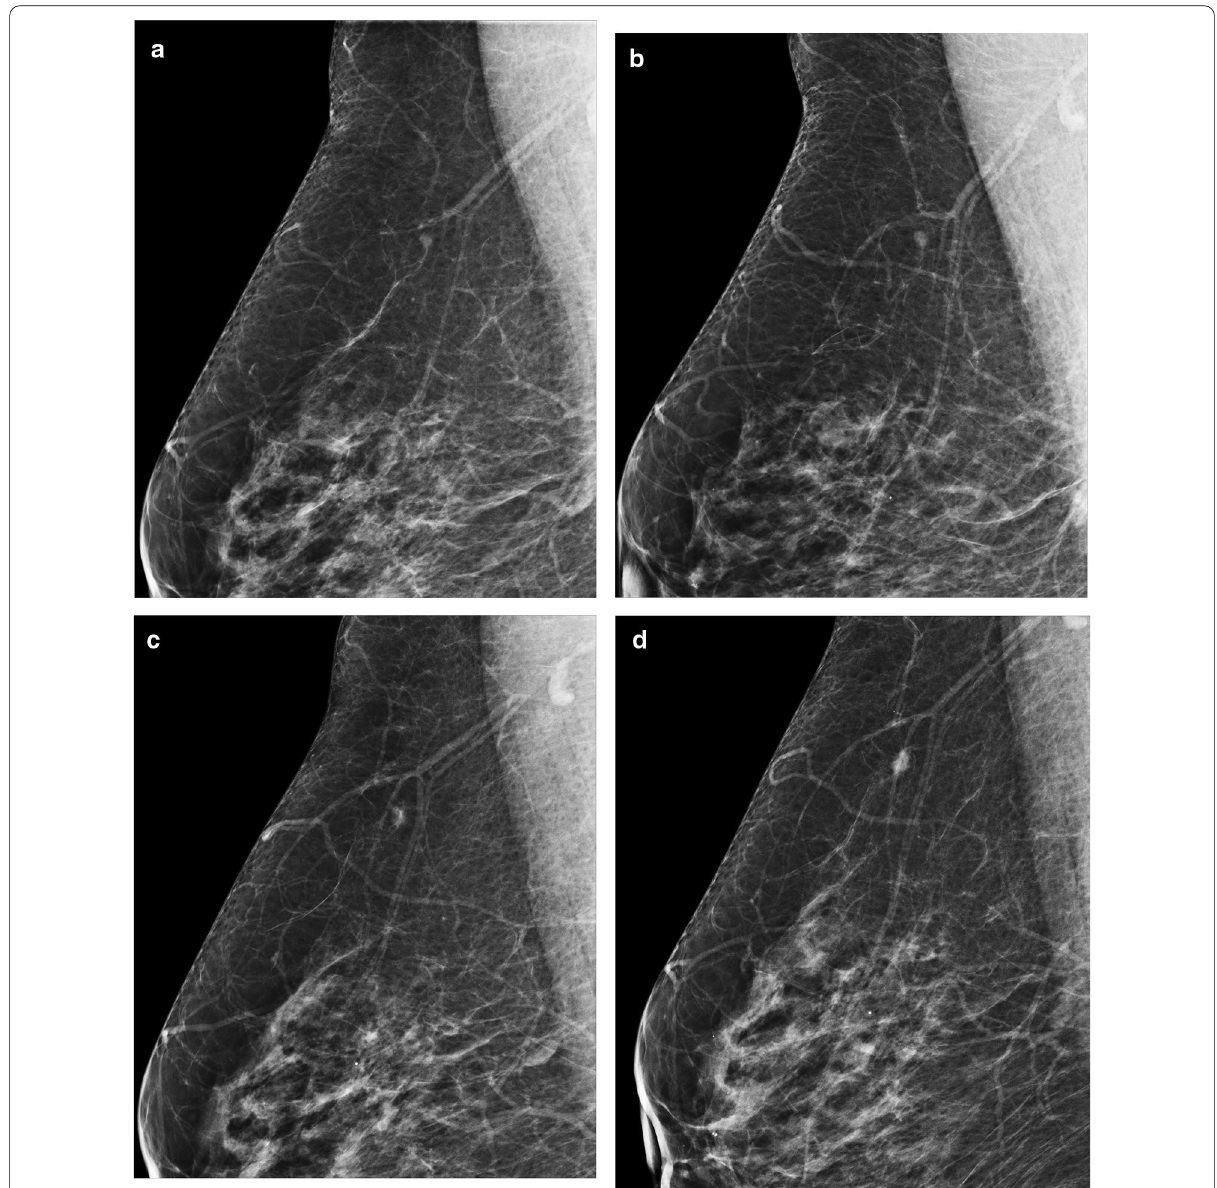
Fig. 1 A millimetric density was observed in the upper quadrant of the right breast in annual serial mammograms. a A small nodular density mimics an IMLN. b Minor difference in size and density. c Increase in density and partially obscured margins. d Significant increase in size and density, indistinct margins, particularly at the anterior part of the